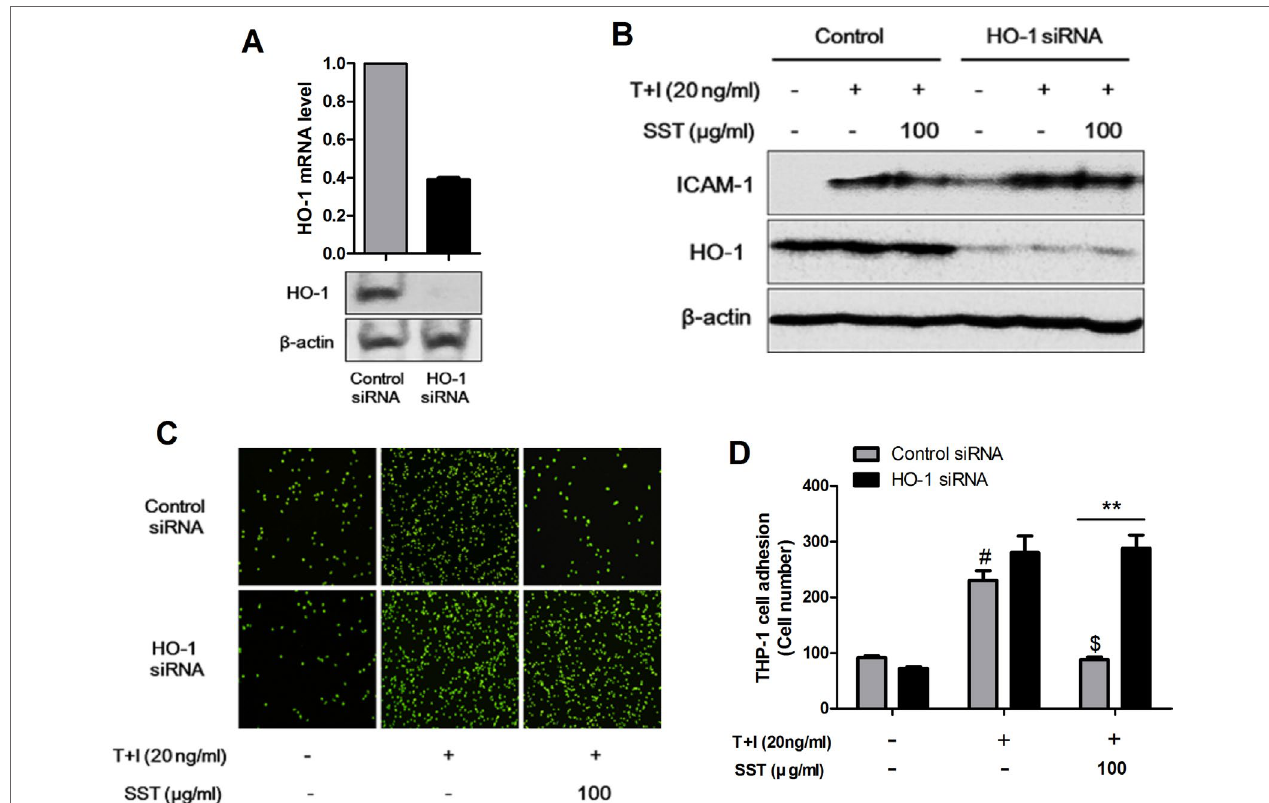
FIGURE 4 | Inhibitory effects of SST on ICAM-1 expression and monocyte adhesion through HO-1. HaCaT cells were transfected with control siRNA and HO-1 siRNA for 48 h. The levels of HO-1 mRNA and protein were confirmed using real-time PCR and western blot (A) . HaCaT cells were transfected with control siRNA and HO-1 siRNA and incubated for 48 h. Cells were pretreated with SST for 30 min, followed by stimulation with TNF- α /IFN- γ for 24 h. The protein levels of ICAM-1, HO-1, and β -actin were determined using western blotting (B) . Control siRNA- and HO-1 siRNA-transfected HaCaT cells were pretreated with SST for 30 min, followed by treatment with TNF- α /IFN- γ for 24 h. Then, fluorescent-labeled THP-1 cells were added to the HaCaT cells and incubated for 30 min at 37°C. After incubation, the co-cultured cells were washed with PBS to remove the non-adherent cells. The adherent cells were counted, and the graph is expressed as a percentage of the control (C, D) . The data are shown as mean ± SEM of triplicate experiment. # p < 0.05 vs. no-treatment condition, $ p < 0.05 vs. only TNF- α /IFN- γ treatment condition, **p < 0.01 vs. Control siRNA transfected